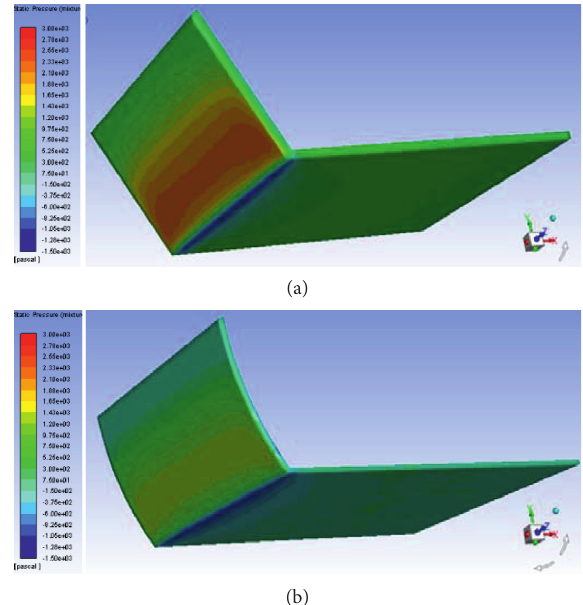
Figure 8: Static pressure distribution diagram: (a) static pressure distribution diagram of floating plate and (b) static pressure dis- tribution diagram of floating plate with 20 degrees of curved